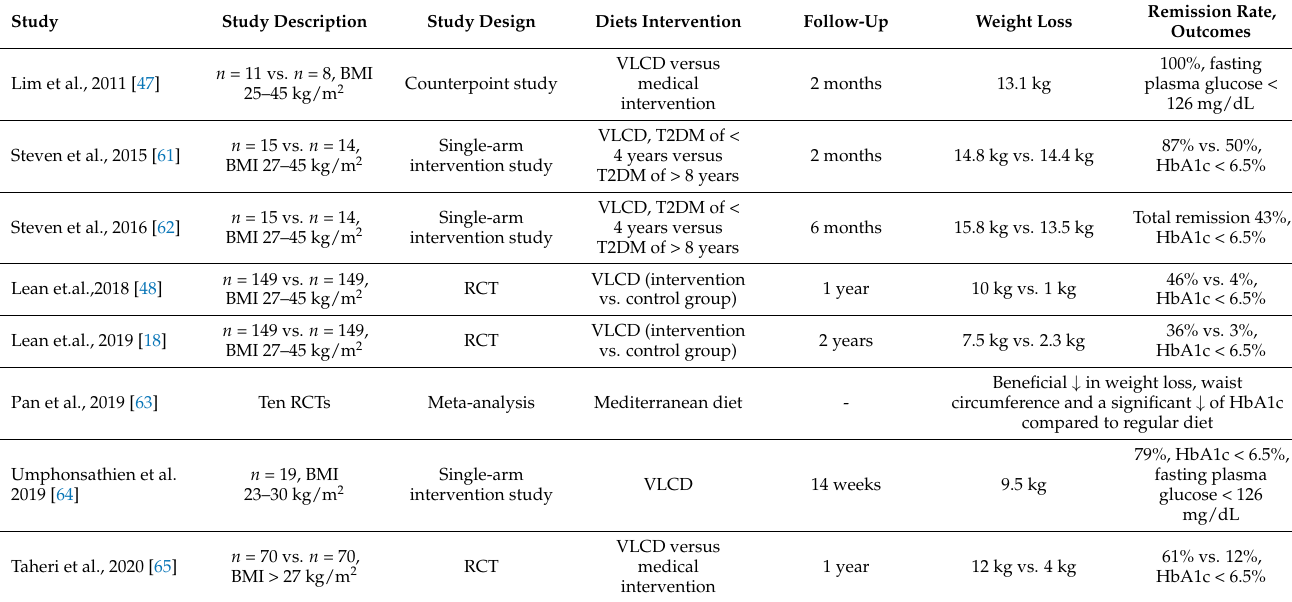
Table 2. Studies that have investigated the efficacy of dietary interventions in inducing